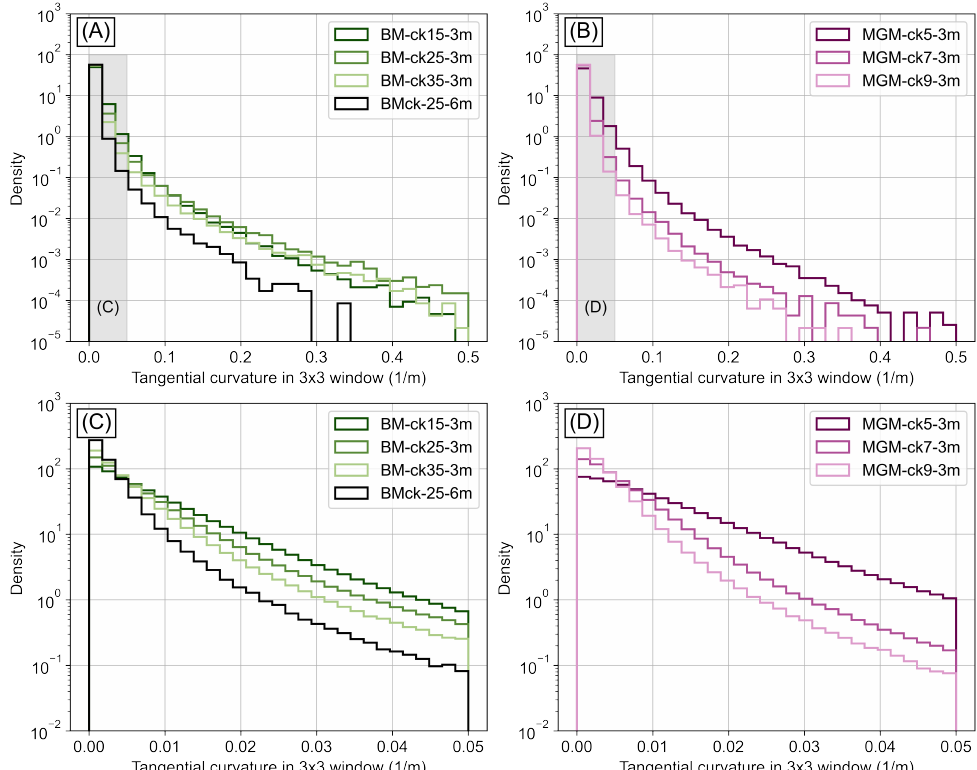
Figure 9. Distributions of tangential curvature calculated in a 3 × 3 pixel window for the entire area of DEMs (including mountains in the study area; cf. Figure 1B). Distribution in the 0–0.5 m − 1 range for ( A ) BM results and ( B ) MGM results, with gray bar showing the 0–0.05 m − 1 zoomed areas in ( C ) for the BM results and ( D ) for the MGM